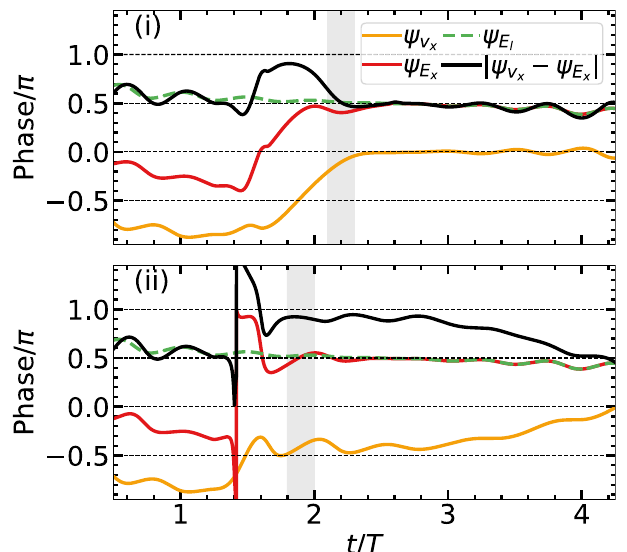
, ψ E , ψ E of respective v x , E x , E l associated with the same RSM x x l 0.0569 (ECR case). z B ext = |ˆ | ≈ ψ E ψ v , on an average, stays close to π (or 0.75 π ) for a short-while x | x − = |